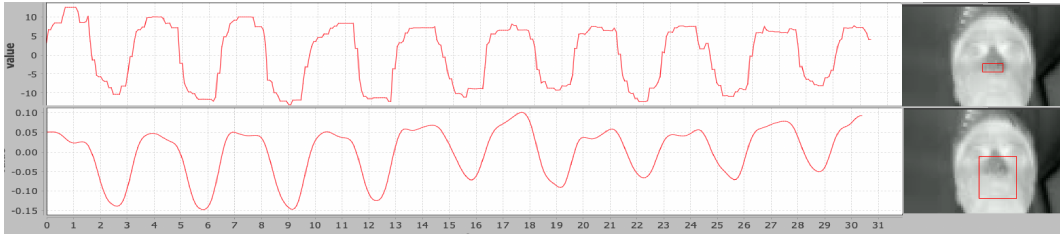
Figure 1. Comparison of the region of interest (ROI) selection for different aggregation operations used to obtain raw signals from which RR valuess were extracted. Top : average; bottom : skewness aggregation operator - the selected ROI and the extracted